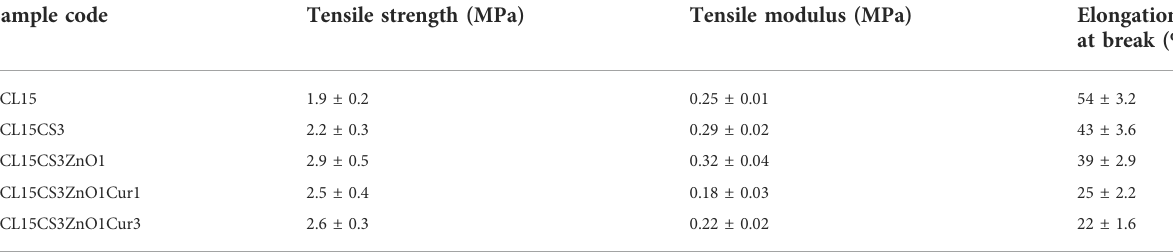
TABLE 3 Mechanical properties of the electrospun nano fi bers. Sample